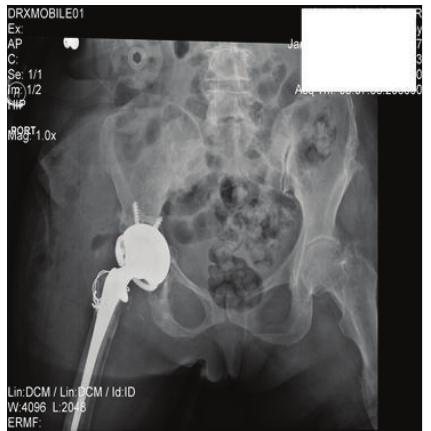
Figure 8: Re-revision surgery status after constrained